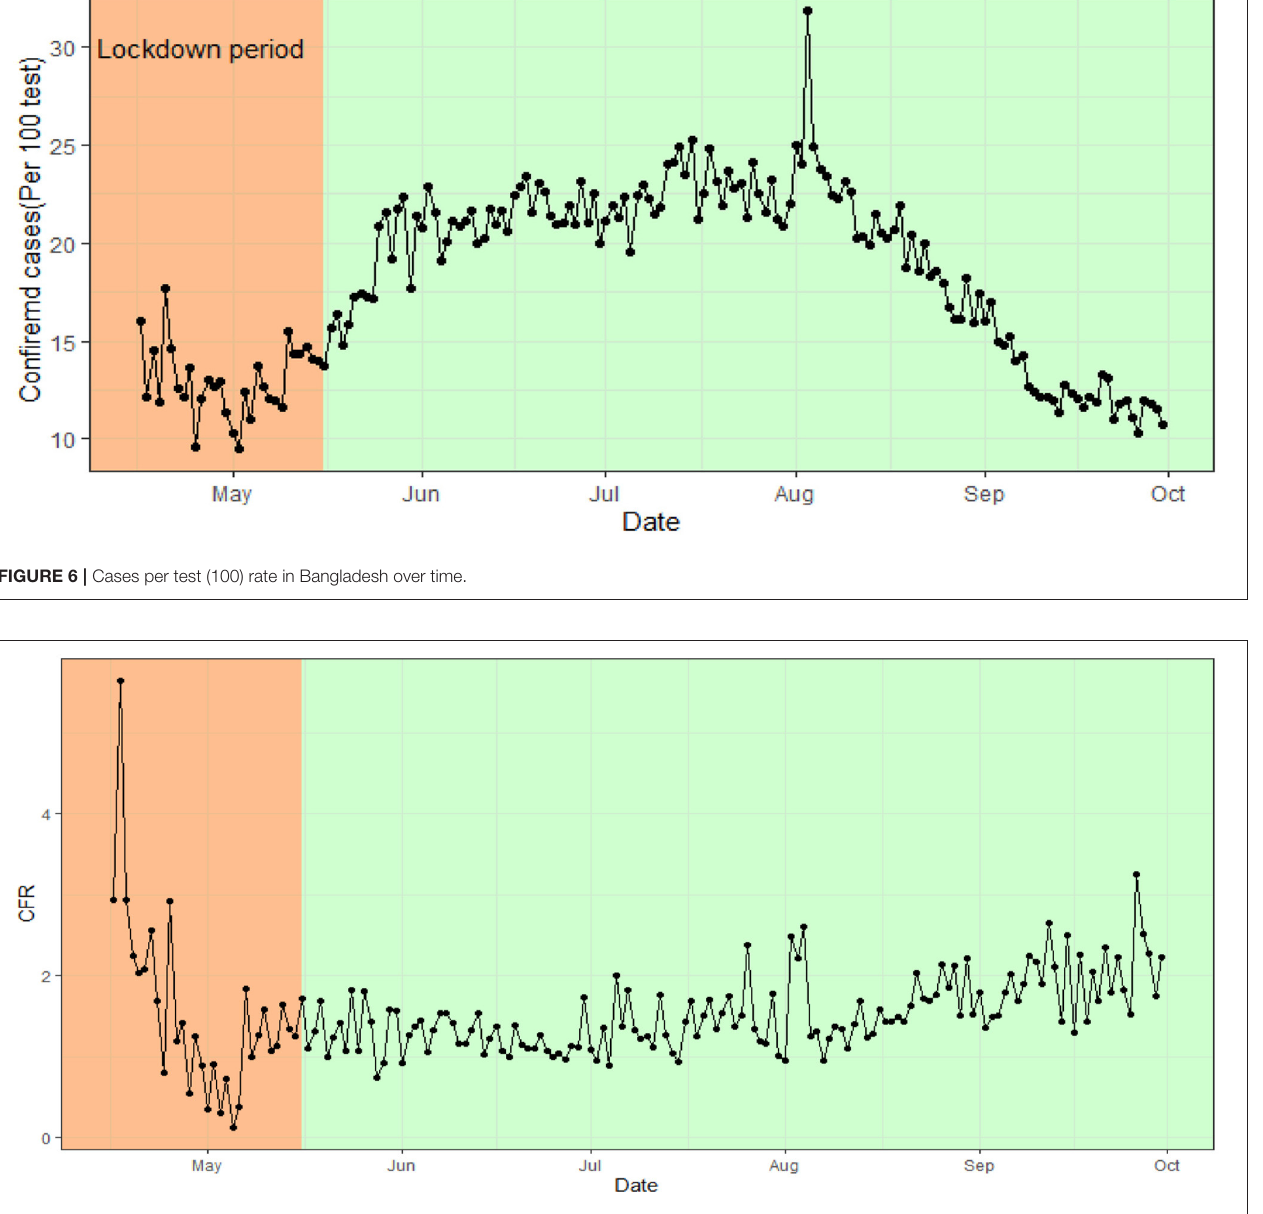
FIGURE 7 | Case fatality ratio in Bangladesh over